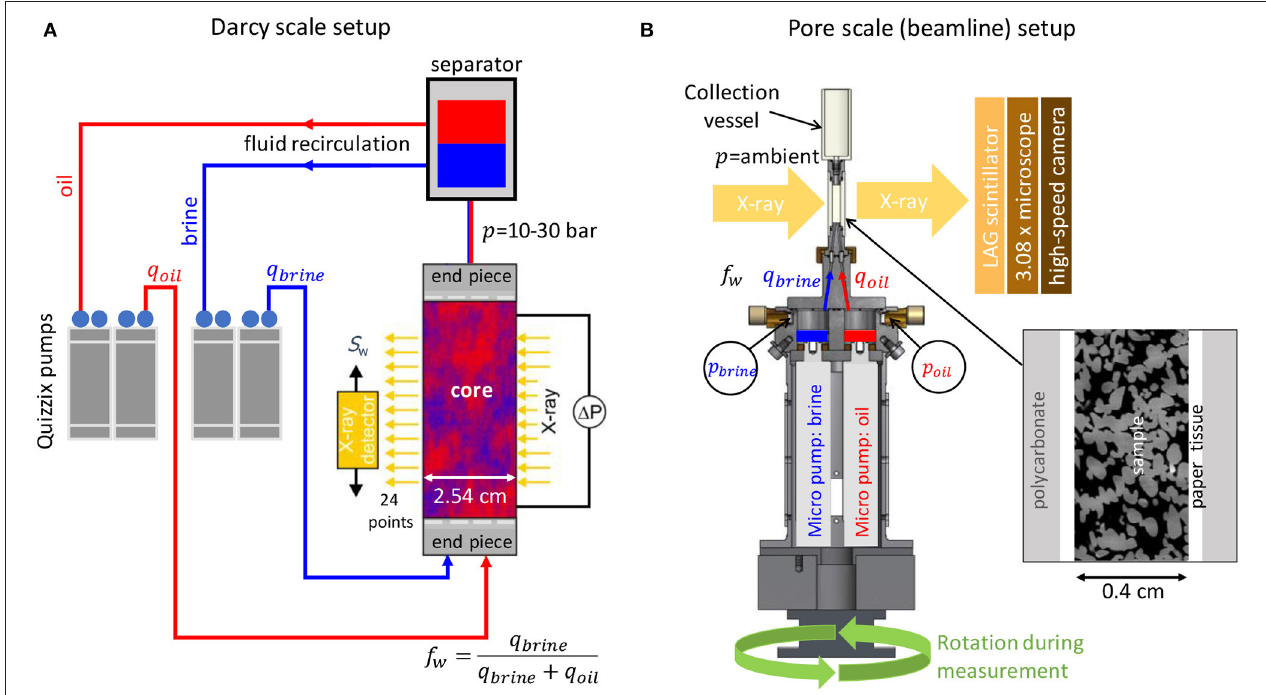
FIGURE 1 | Experimental setups for the Darcy-scale fractional flow “SCAL” experiments (A) and pore scale “beamline” experiments (B) . In the Darcy-scale experiments oil and brine are co-injected at varying flow rates and fractional flow f w with 2 dual-piston Quizzix pumps that operate with zero-dead volume switching valves for smooth and pulse-free continuous flow. Fluids are re-circulated (after separation) without any back-pressure controller. Saturation is measured in-situ during the experiment using a linear X-ray scanner. The micro-CT setup (B) uses a core holder with 2 integrated micro-pumps ( Berg et al., 2013) for water and oil co-injection at specified fractional flow f w . At the outlet side the fluids are collected at ambient pressure, i.e., no back-pressure control system is used. The porous sample is wrapped with paper (for a hydrophilic boundary condition) and heat-shrunk into a poly-carbonate cylinder. The setup is self-contained as it is rotating during the micro-CT scans, i.e., no external flow lines are used. Power is supplied via slip rings and the pressure sensor readings are transmitted with a wireless